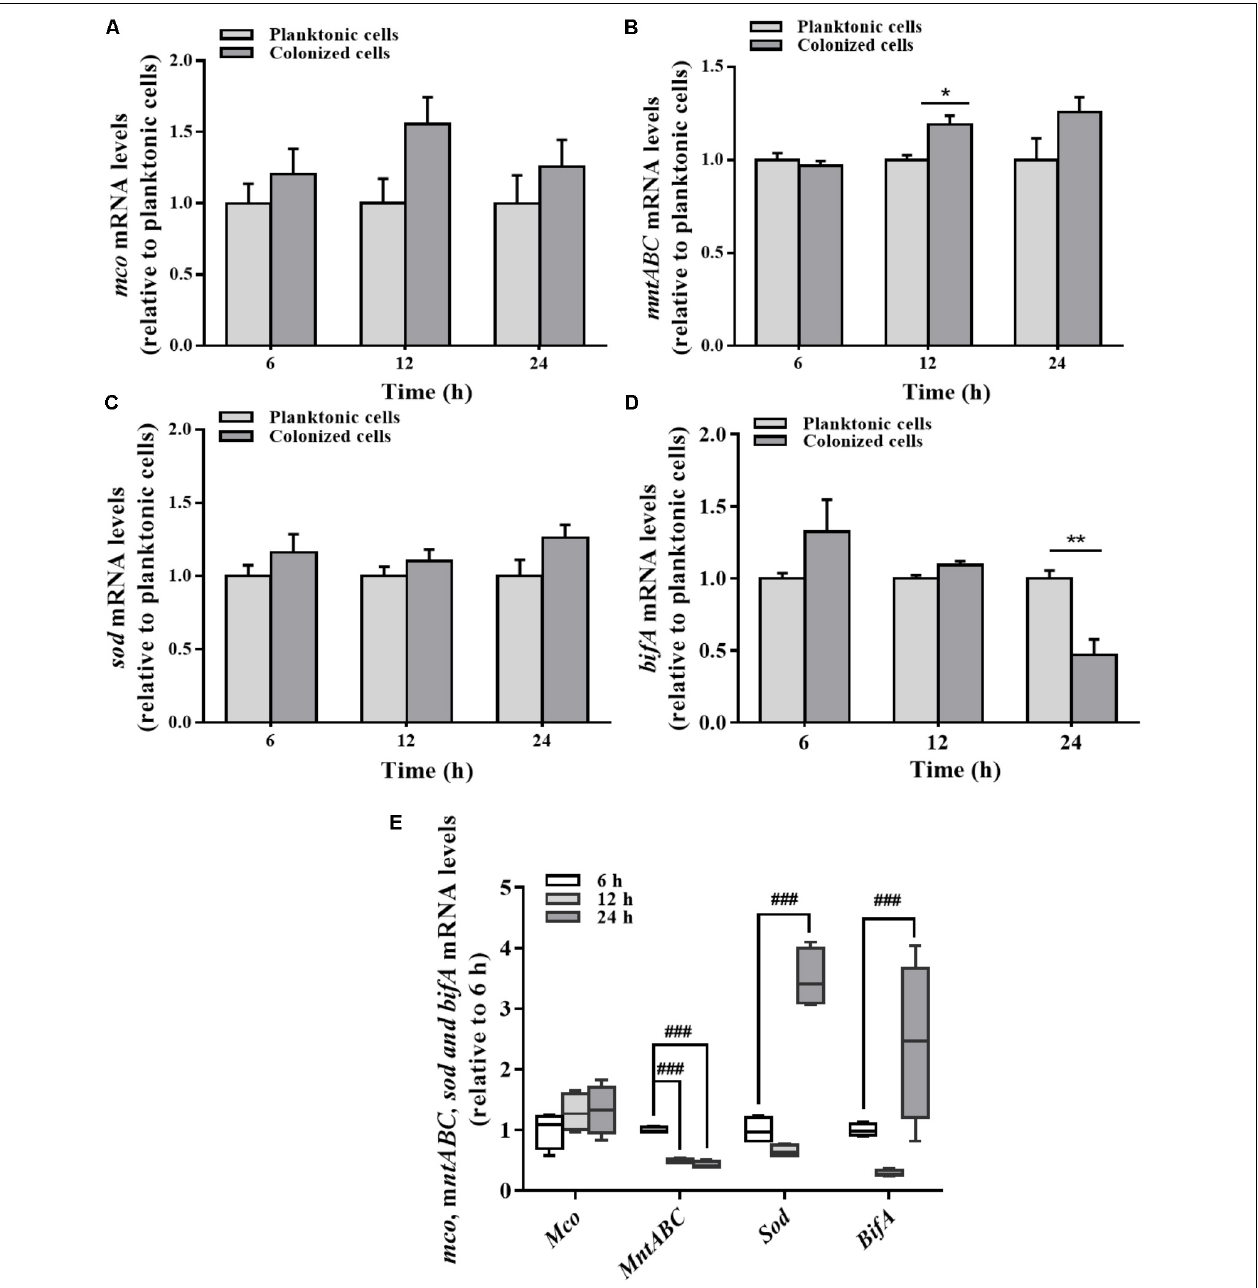
FIGURE 5 | Expression of mco, mntABC , sod, and bifA gene between the planktonic and biofilm lifestyles as well as during biofilm development. mco (A) , mntABC (B) , sod (C) , and bifA (D) mRNA levels in planktonic cells and colonized cells at 6, 12, and 24 h incubation were determined by qRT-PCR, respectively. (E) The cellular mRNA levels of mco, mntABC , sod and bifA during biofilm development in the colonized cells were determined by qRT-PCR. These expression levels were normalized to 16s rRNA ( n = 4). Data were expressed as mean ± SEM. Significance, ∗ P < 0.05, ∗∗ P < 0.01, and ∗∗∗ P < 0.001 vs. planktonic cell group. ## P < 0.01 and ### P < 0.001 vs. 6 h-biofilm formation